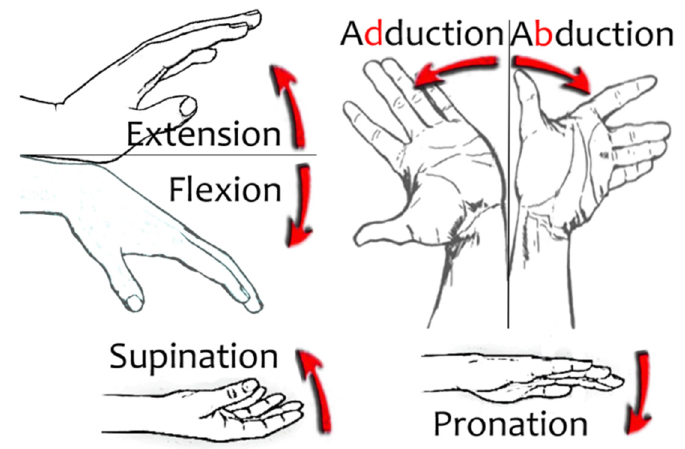
Figure 4. Wrist movements.